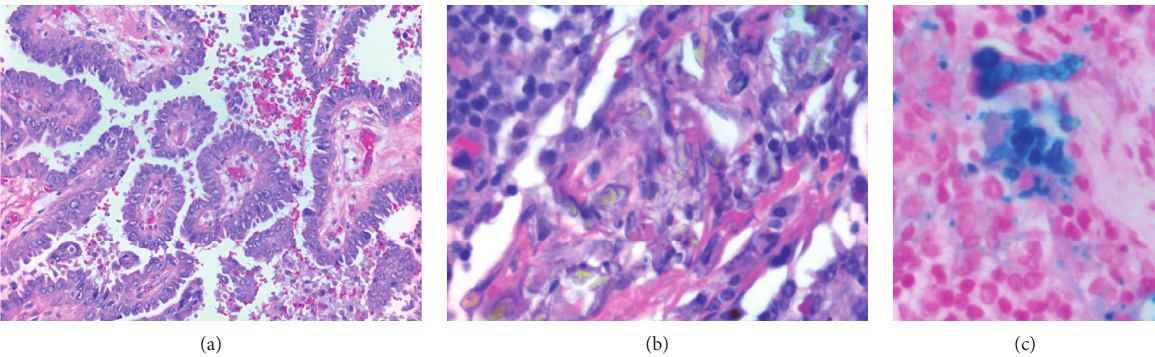
Figure 1: H&E staining of (a) primary breast carcinoma under high magnification demonstrating papillary architecture and nuclear pleomorphism. (b) Lymph node with what appears to be branching fungal forms. (c) Perl’s iron stain of lymph node under high power showing septated, hyphae-like